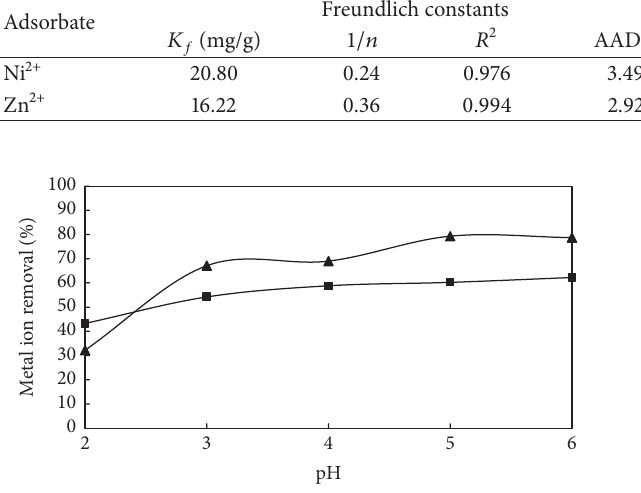
Figure 5: Percentage of Ni 2+ ( ◼ ) and Zn 2+ ( 󳵳 ) ions removal with varying contact